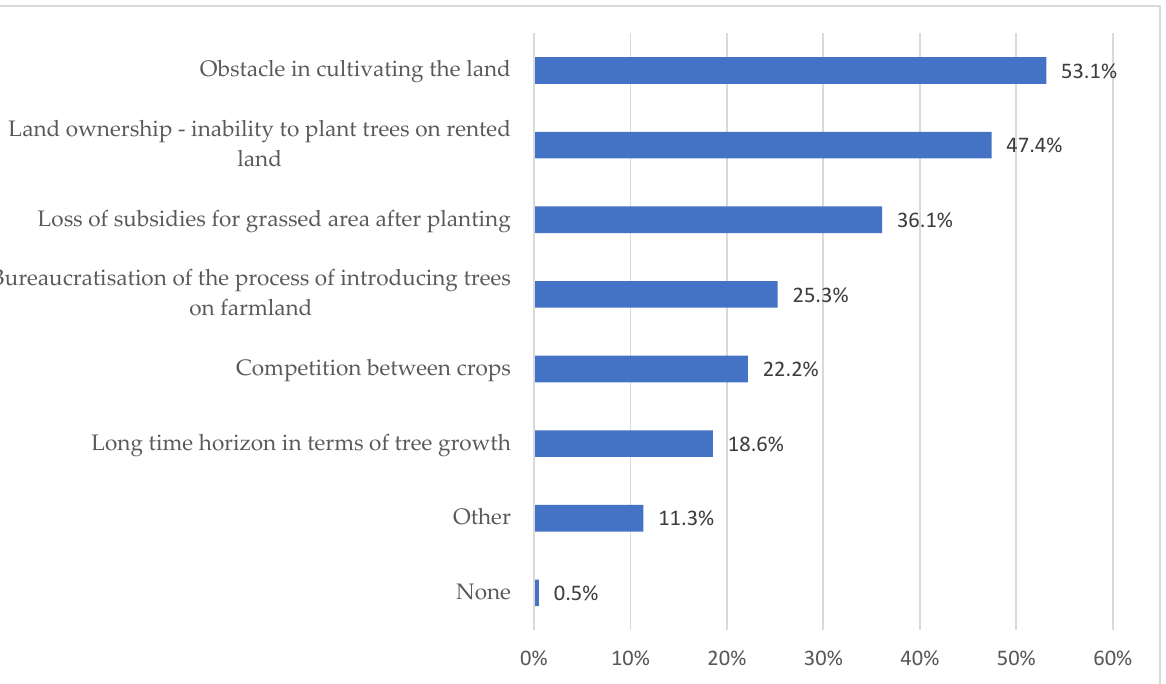
Figure 3. The most important problems of planting trees on agricultural land (multiple answers; n = 194).